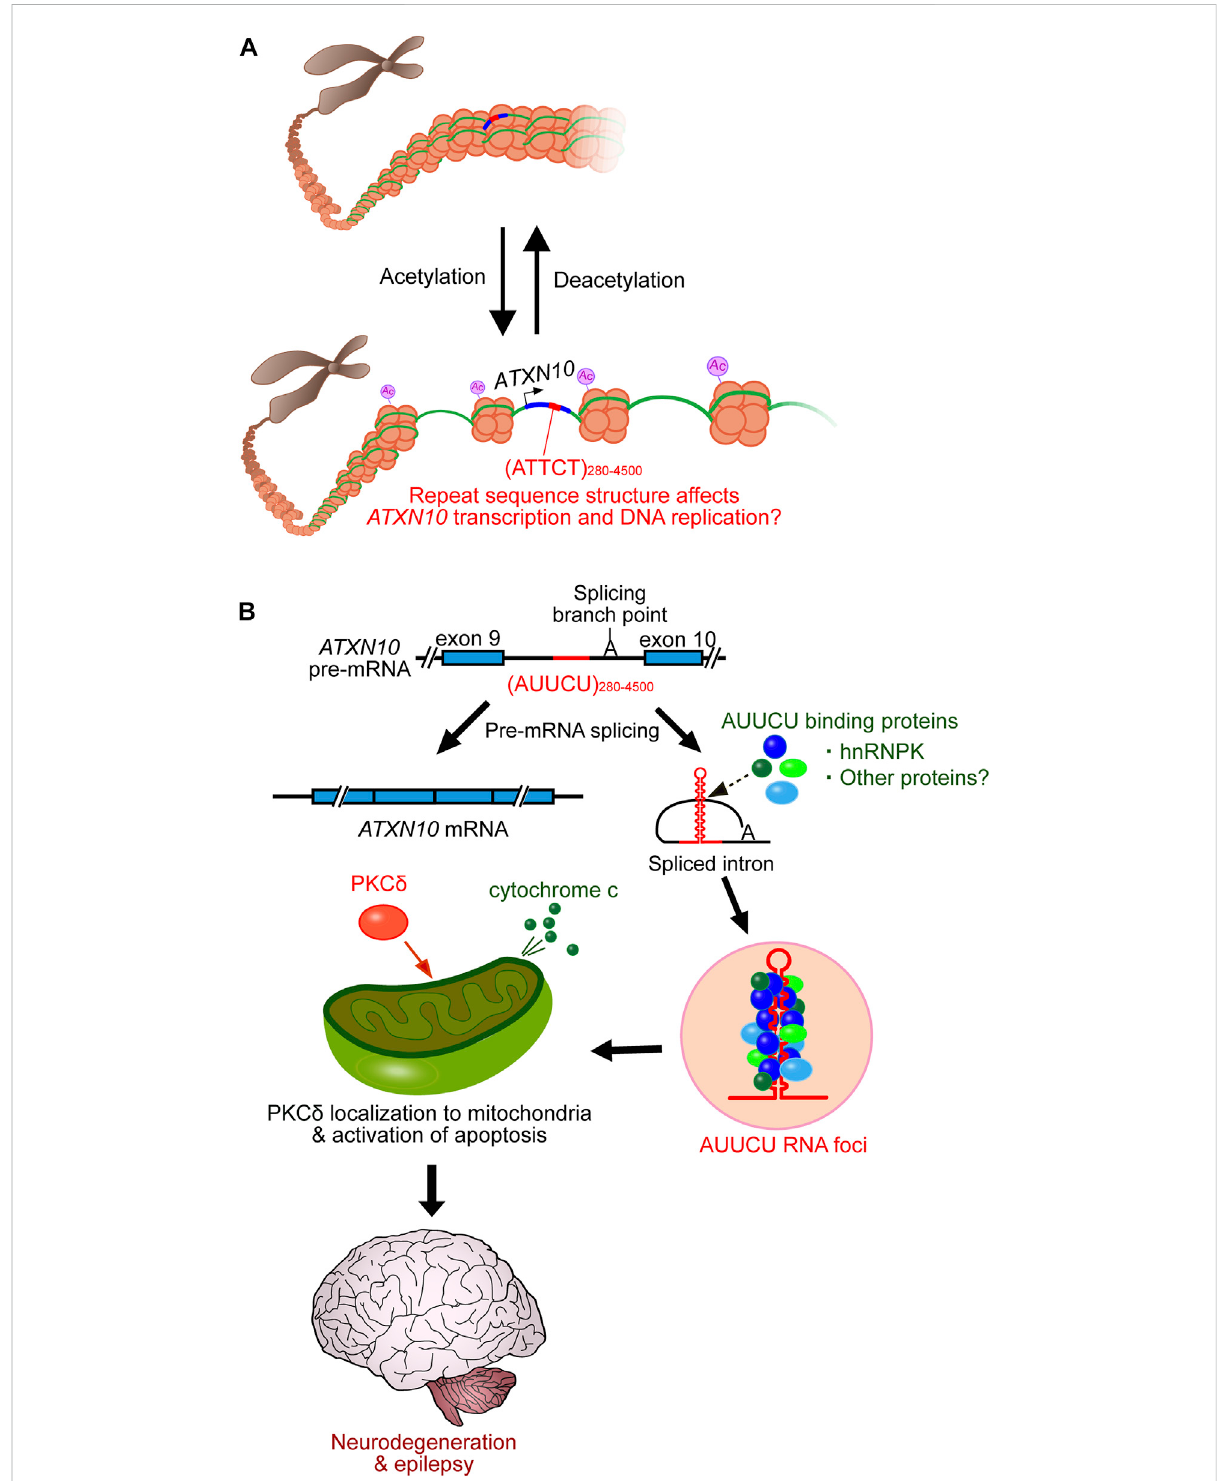
FIGURE 2 SCA10 disease model. (A) SCA10 ATTCT repeat expansion promotes histone acetylation, which subsequently enhances transcription and DNA replication,whichmaybeaffectedbyrepeatinterruptions. (B) ExpandedAUUCUrepeatstraphnRNPKinRNAaccumulations(RNAfoci).Dysfunction of hnRNPK induces PKC δ localization to mitochondria, which subsequently triggers cytochrome c release from mitochondria, activating apoptosis and eventually triggering